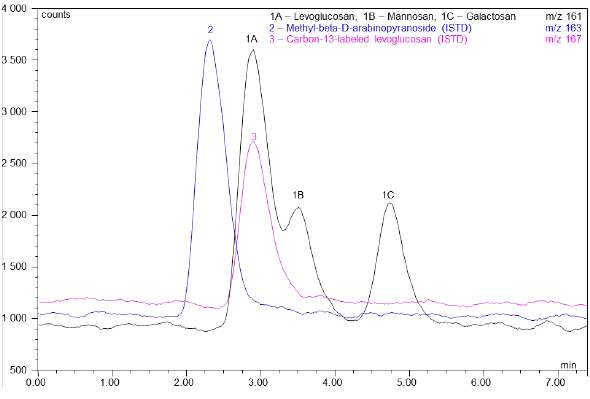
Fig. 2. Chromatogram of the MAs and the two ISTD compounds with the HPAEC–MS.